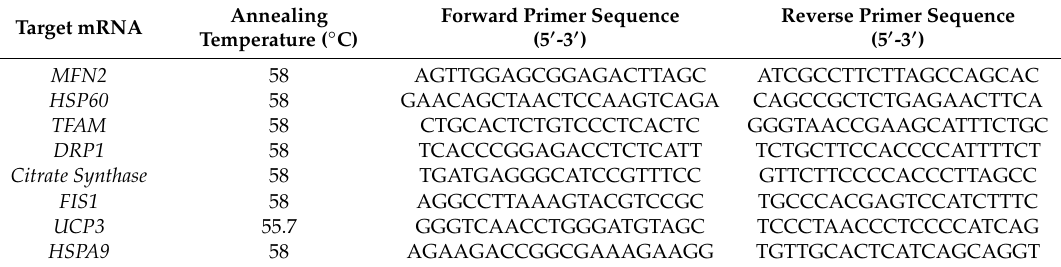
Table 1. The sequences and annealing temperature of mitochondrial-associated primers.